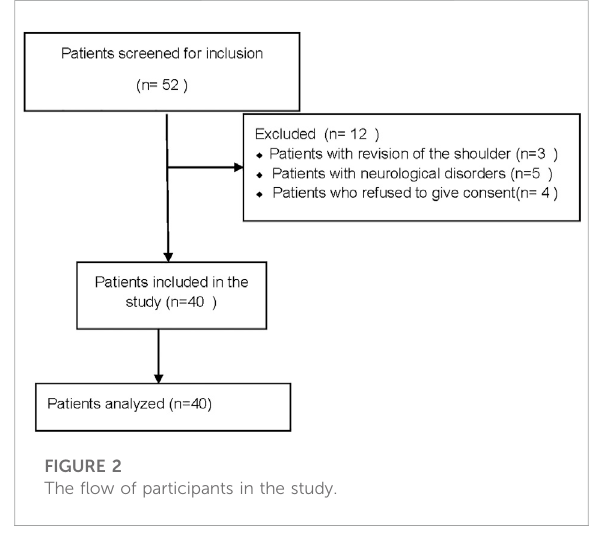
FIGURE 2 The fl ow of participants in the study.